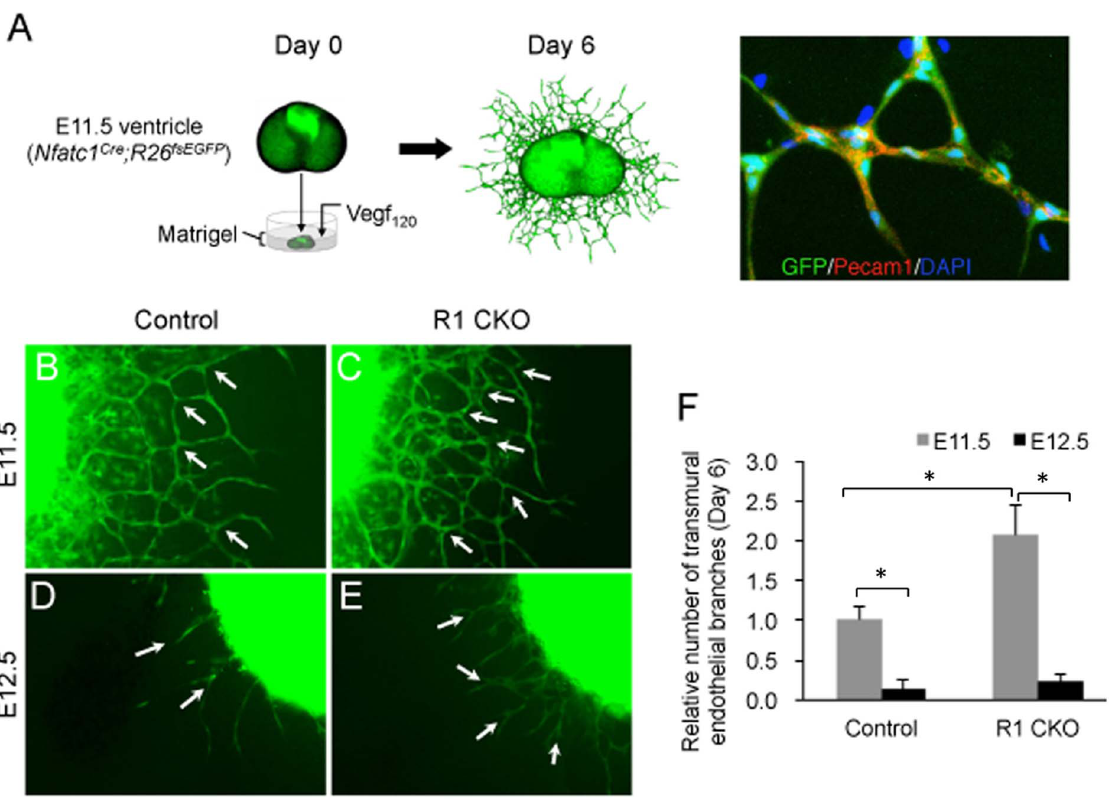
Figure 6. R1 CKO endocardial cells form excessive coronary plexuses by augmented coronary angiogenesis. A, Schematic diagram and EGFP/Pecam1 double labeling illustrating that Vegf 120 promotes angiogenesis by the genetically labeled ventricular endocardial cells in the Matrigel culture of E11.5 Nfatc1 Cre ;R26 fsEGFP ventricle to form endothelial tubular networks. B, C, Images of endothelial networks developed from the cultured ventricles of the E11.5 Nfatc1 Cre ;R26 fsEGFP (control) ( B ) or Nfatc1 Cre ;R26 fsEGFP ;Vegfr1 f/f (R1 CKO) embryos ( C ) showing excessive endothelial tube formation (arrows) by the R1 CKO endocardial cells. D , E, Images of E12.5 ventricular explants showing that endothelial tube formation by the endocardial cells are greatly reduced in both control ( D ) and R1 CKO ( E ) hearts, although R1 CKO ventricles still form more endothelial tubes. F, Statistical analysis showing that angiogenic branching occurs mainly at E11.5 and the process is reduced significantly at E12.5. Of note, there is significantly increased endothelial branching by the R1 CKO endocardial cells at E11.5. n =5 ventricular explants per group, * p , 0.01, error